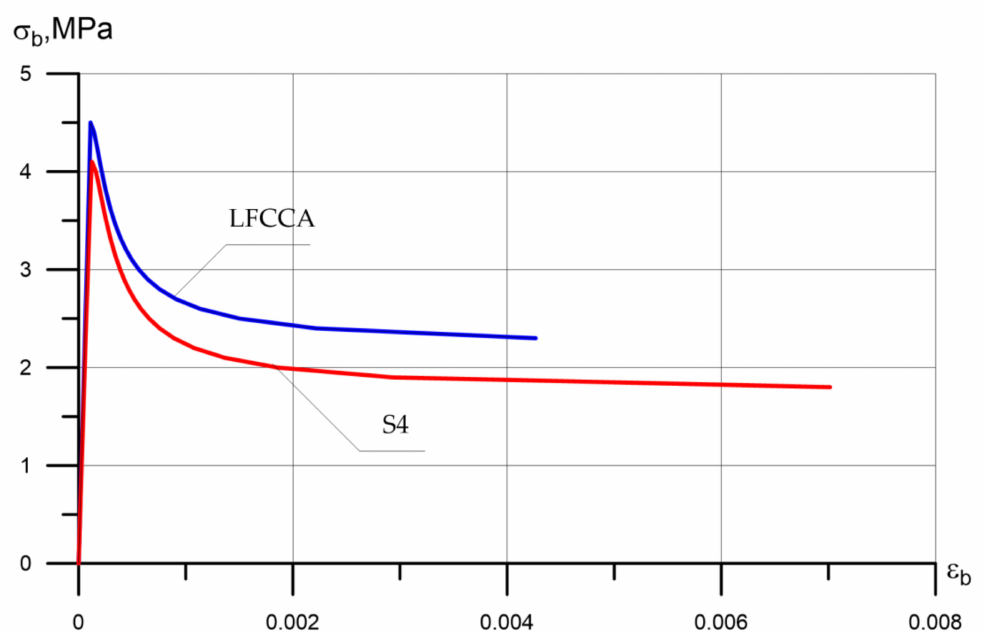
Figure 14. Diagram of the state of tensioned concrete (S4—control composition of concrete; LFCCA— LFRC on a combined